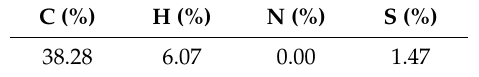
Table 1. Percentages of the content of C, H, N, and S for the sulfonated derivative.